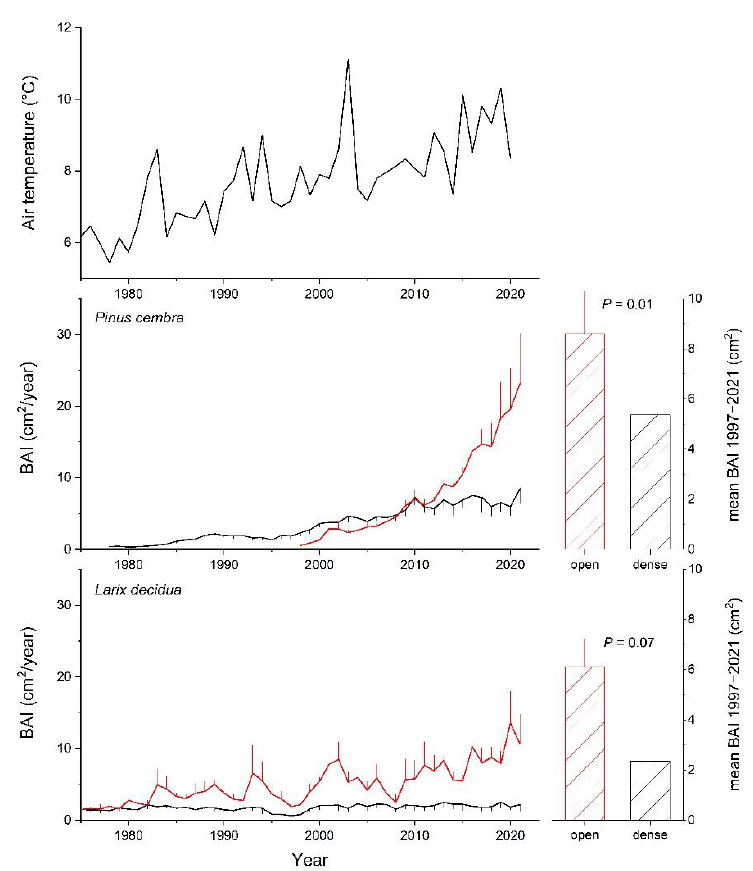
Figure 2. Temporal variation in seasonal mean summer (June–August) air temperature (top) and (left) basal area increment (BAI) and (right) annual mean BAI for the period 1997–2021 of mature Pinus cembra (middle) and Larix decidua (bottom) trees growing in open (red) and dense (black) stands at treeline on Mt. Patscherkofel, Central Tyrolean Alps (47°12 ′ 33 ″ N; 11°27 ′ 40 ″ E). BAI values estimated according to [41,42] are the mean ± SE of 3 trees. P < 0.10 was regarded as significant according to recommendations of [43] for small sample sizes. Authors unpublished observations.